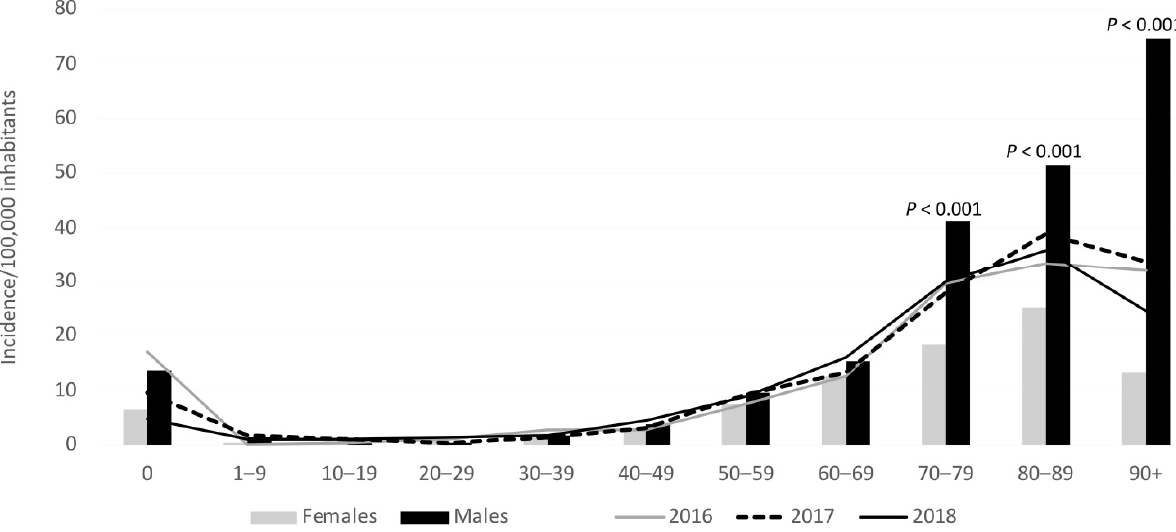
Figure 3. Age- and gender-specific episode rates in 2016–2018 (bars) and age-specific incidences each year (lines). Incidences are determined based on the number of episodes per inhabitants in the specific age and gender groups. Population data for the age group 90+ are based on the number of inhabitants from 90 years up to 109 years old. The p -values are stated when statistically significant between genders in the specific age group.